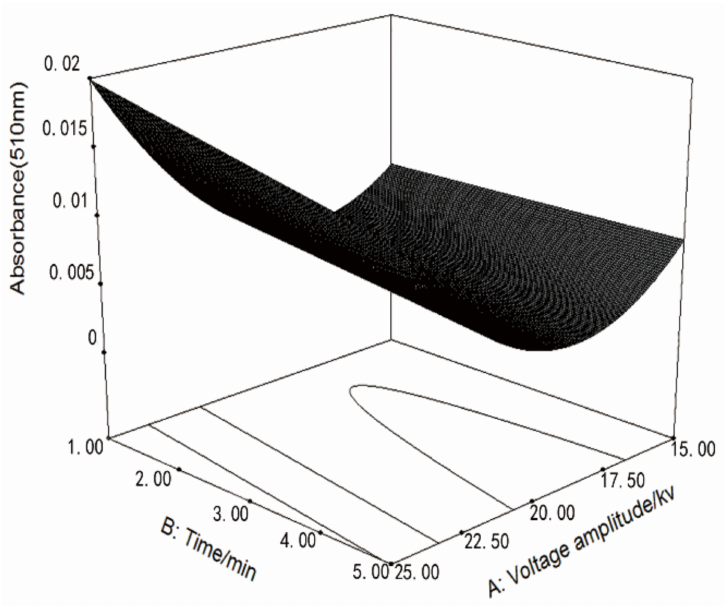
Figure 5. Response surface analysis of voltage amplitude and processing